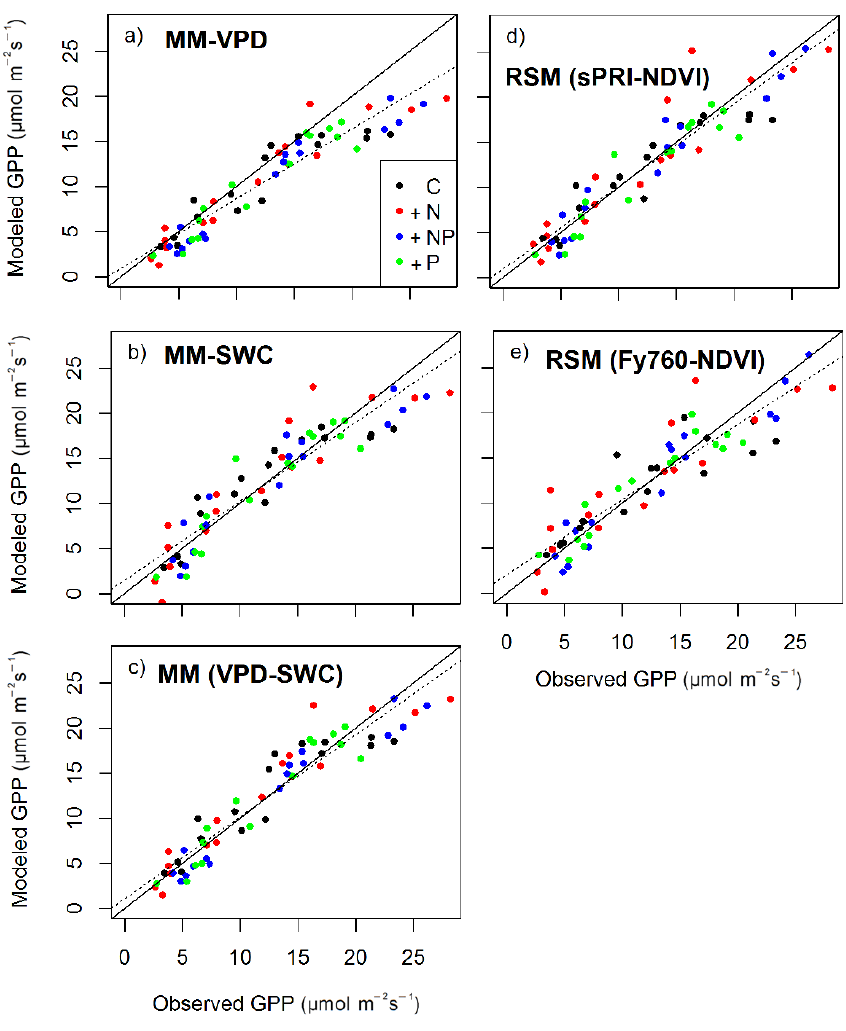
Figure 6. Comparison between measured GPP and GPP modeled with the best performing LUE model for each kind of formulation: MM (VPD, a ), MM (SWC, b ), MM (including VPD and SWC, panel c ), RSM (sPRI-NDVI, d ), and RSM (Fy760-NDVI, e ). Results from the cross-validation analysis are presented in Table